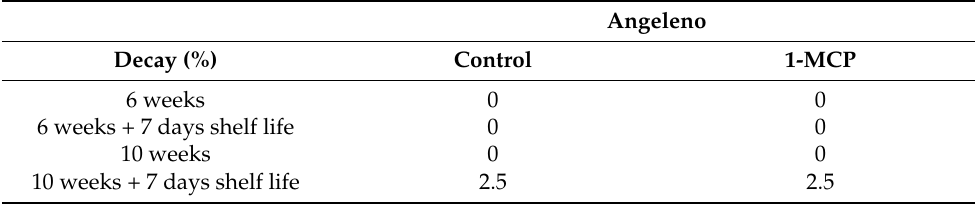
Table 1. Decay of ’Angeleno’ plum during